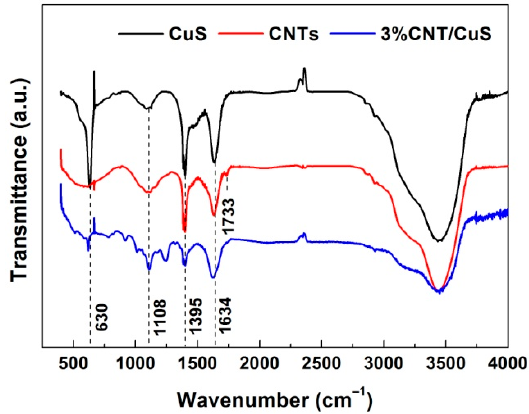
◦ C), CNTs and 3% CNT / CuS.